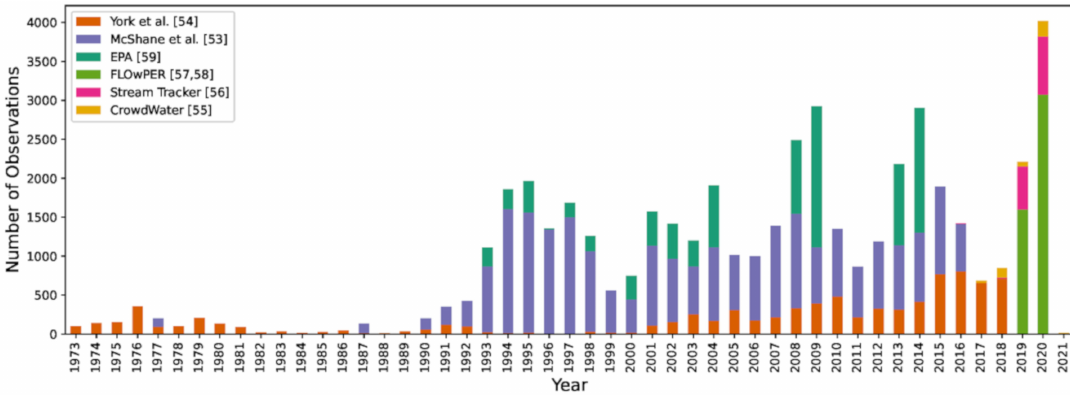
Figure 4. Time series of surface water presence observations colored by source. Note, only CrowdWater observations located in the United States and shown in Figure 3 are included here. McShane et al. [53] and York et al. [54] are flow/no flow observation datasets originally aggregated from several local, state, tribal, and federal agencies to support PROSPER model